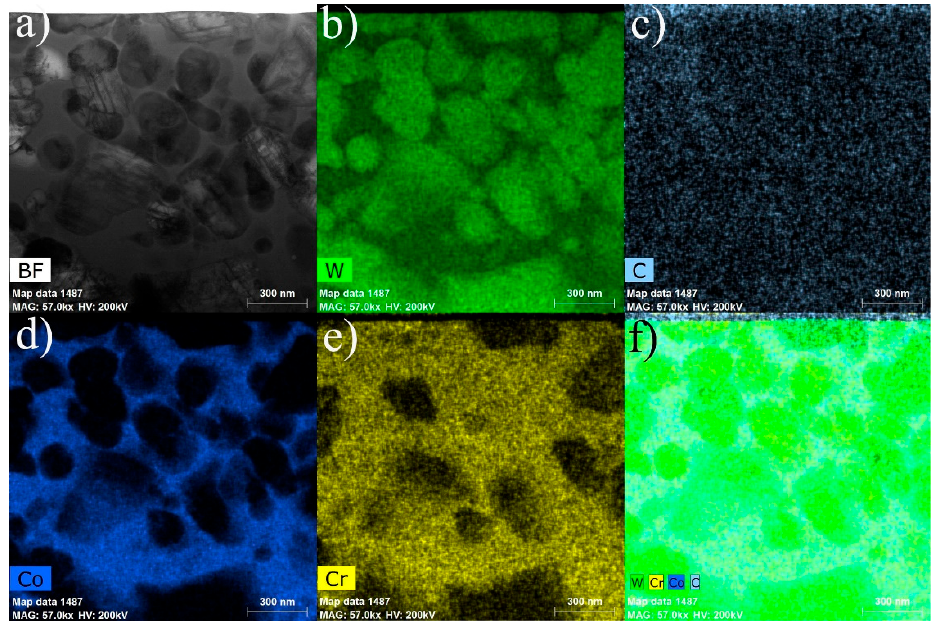
Figure 4. ( a ) TEM image of microstructure; EDS mapping of WC-based cermet area in the composite coating: ( b ) W; ( c ) C; ( d ) Co; ( e ) Cr; ( f ) A combined elemental mapping of W, C, Co and Cr.